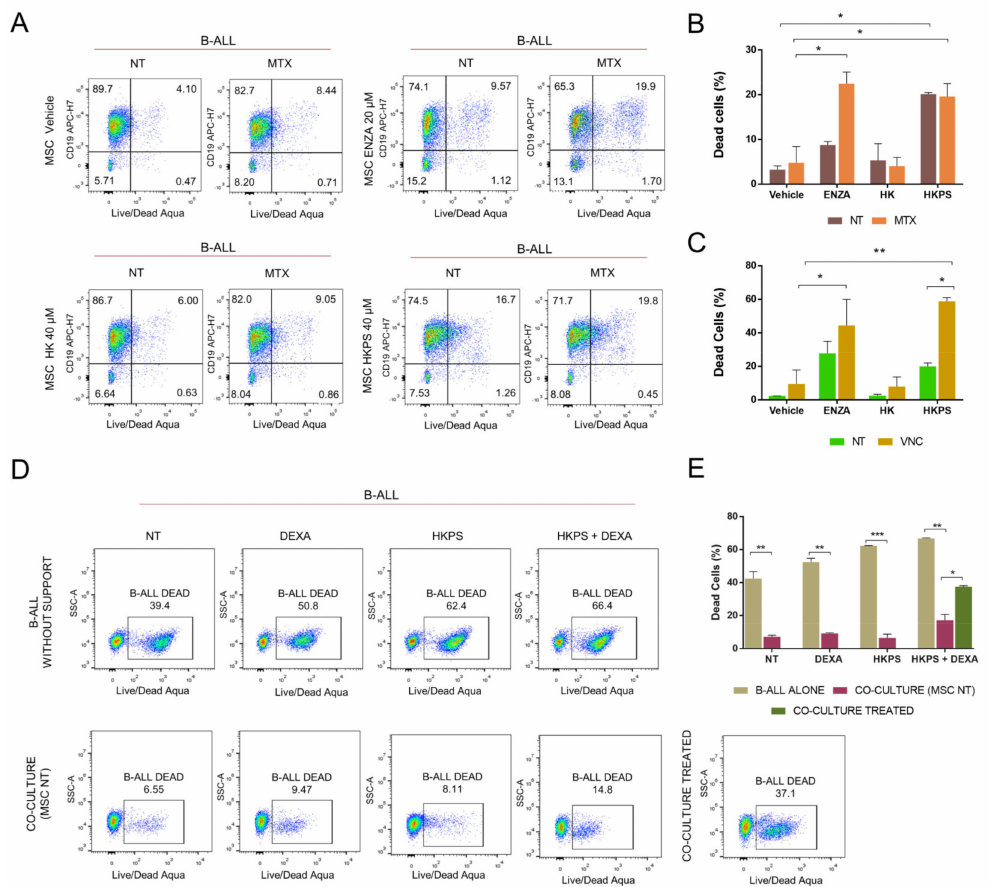
Figure 1. B-ALL cells show increased susceptibility to conventional chemotherapy after PKC inhi- bition in the mesenchymal support. ( A ) Cell viability of primary B-ALL cells after PKC inhibition and treatment with MTX. As control, B-ALL cells without treatment (NT) were included. MSC were treated with HKPS, the commercial inhibitor ENZA, or the controls for 2 h, as indicated. B-ALL cells, pre-treated 6 h with 6.25 µ M of MTX, were co-cultured for additional 72 h on MSC. Co-cultures were collected after trypsinization and the cell viability was assessed by flow cytometry on the leukemic cell population through the double staining with the reactive LIVE/DEAD Aqua and the anti-CD19 antibody. A representative experiment is shown. ( B ) Quantification of the B-ALL cell population double positive for CD19 and LIVE/DEAD Aqua as described in A. ( C ) Quantification of the viability of the B-ALL cells after inhibition of PKC in MSC with HKPS, HK (40 µ M), ENZA (20 µ M), or the vehicle (0.4% DMSO) and co-culturing for 72 h with B-ALL cells pre-treated with VNC (500 nM). ( D ) Simultaneous effect of DEXA and HKPS on B-ALL cells viability. Leukemic cells were pre-treated for 6 h with DEXA (250 nM), HKPS (40 µ M), or both, and then they were co-cultured for 24 h with non-treated MSC (CO-CULTURE (MSC NT)); also, co-cultures were established and then cells were treated with the combination of HKPS and DEXA (CO-CULTURE TREATED); as controls, B-ALL cells without support were employed (B-ALL ALONE, upper panel). Cell viability was assessed by flow cytometry. A representative experiment is shown. ( E ) Percentages of B-ALL cells viability in the conditions indicated above. Data are expressed as mean ± SEM ( p values: Non-parametric one-way ANOVA. * p < 0.05. ** p < 0.01. *** p < 0.001) from two independent